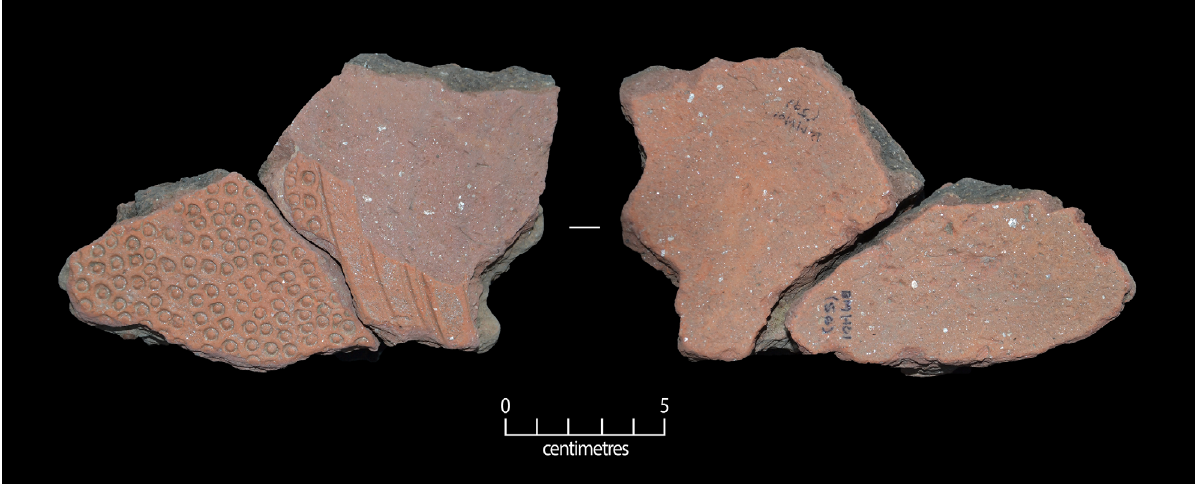
Figure 14: External and internal surfaces of two refitting Class 4 variant 14 potsherds, with decoration on external